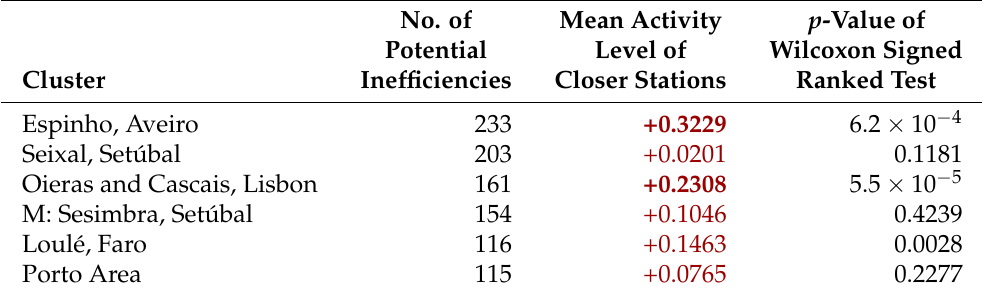
Table 4. Potential inefficiency statistics for VMER vehicles per area cluster. Bold values indicate significance at a 0.01 level. Red values indicate positive activity level.